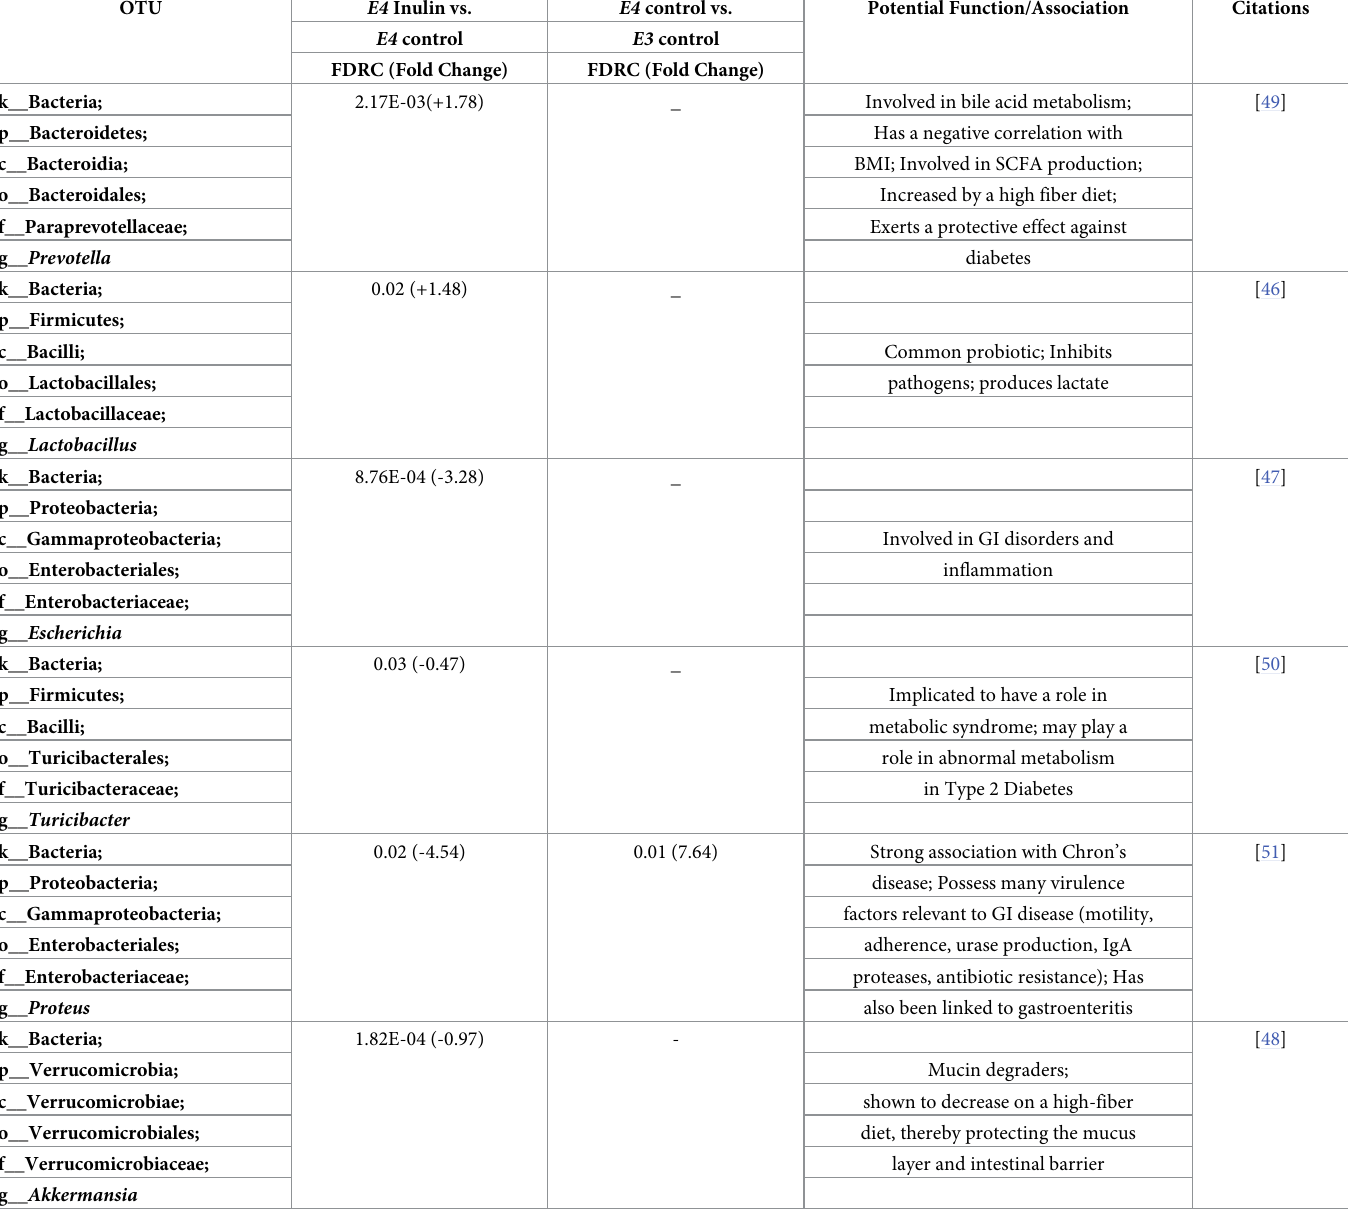
Table 2. Bacterial taxonomic analysis of inulin-induced changes in the gut microbiota of E4 FAD mice. OTU E4 Inulin